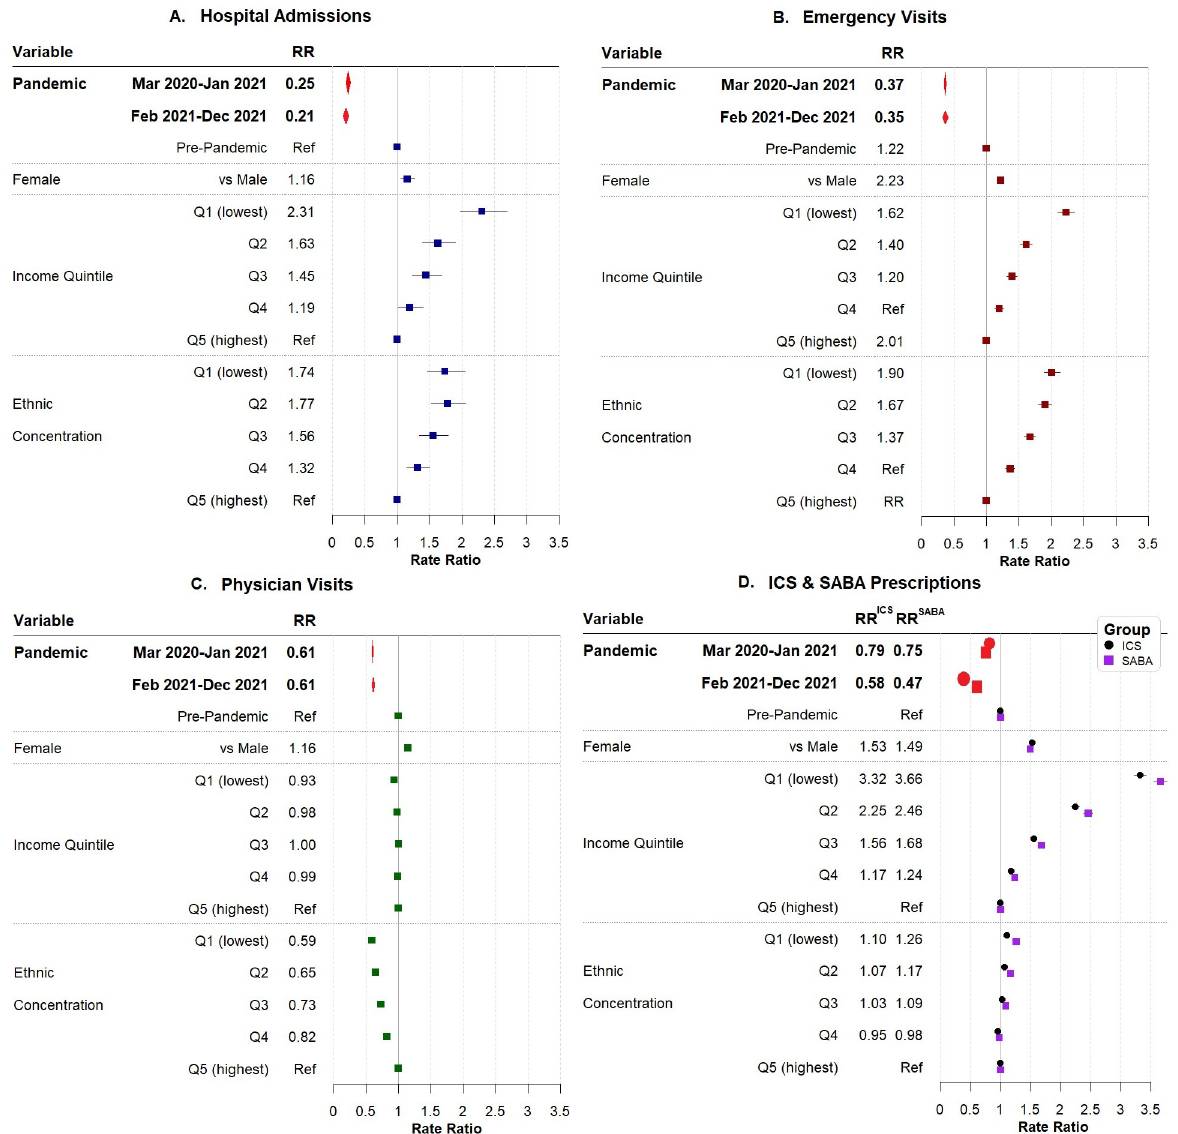
Fig 2. Forest plot of adjusted rate ratios (RR) of asthma health services use based on negative binomial regressions. Abbreviations: Ref = reference; RR = rate ratio; Q1 = first quintile; Q2 = second quintile; Q3 = third quintile; Q4 = fourth quintile; Q5 = fifth quintile; ICS = inhaled corticosteroid; SABA = short-acting beta 2-agonist. Note: All regression models were also adjusted for rural or urban residence and age groups.